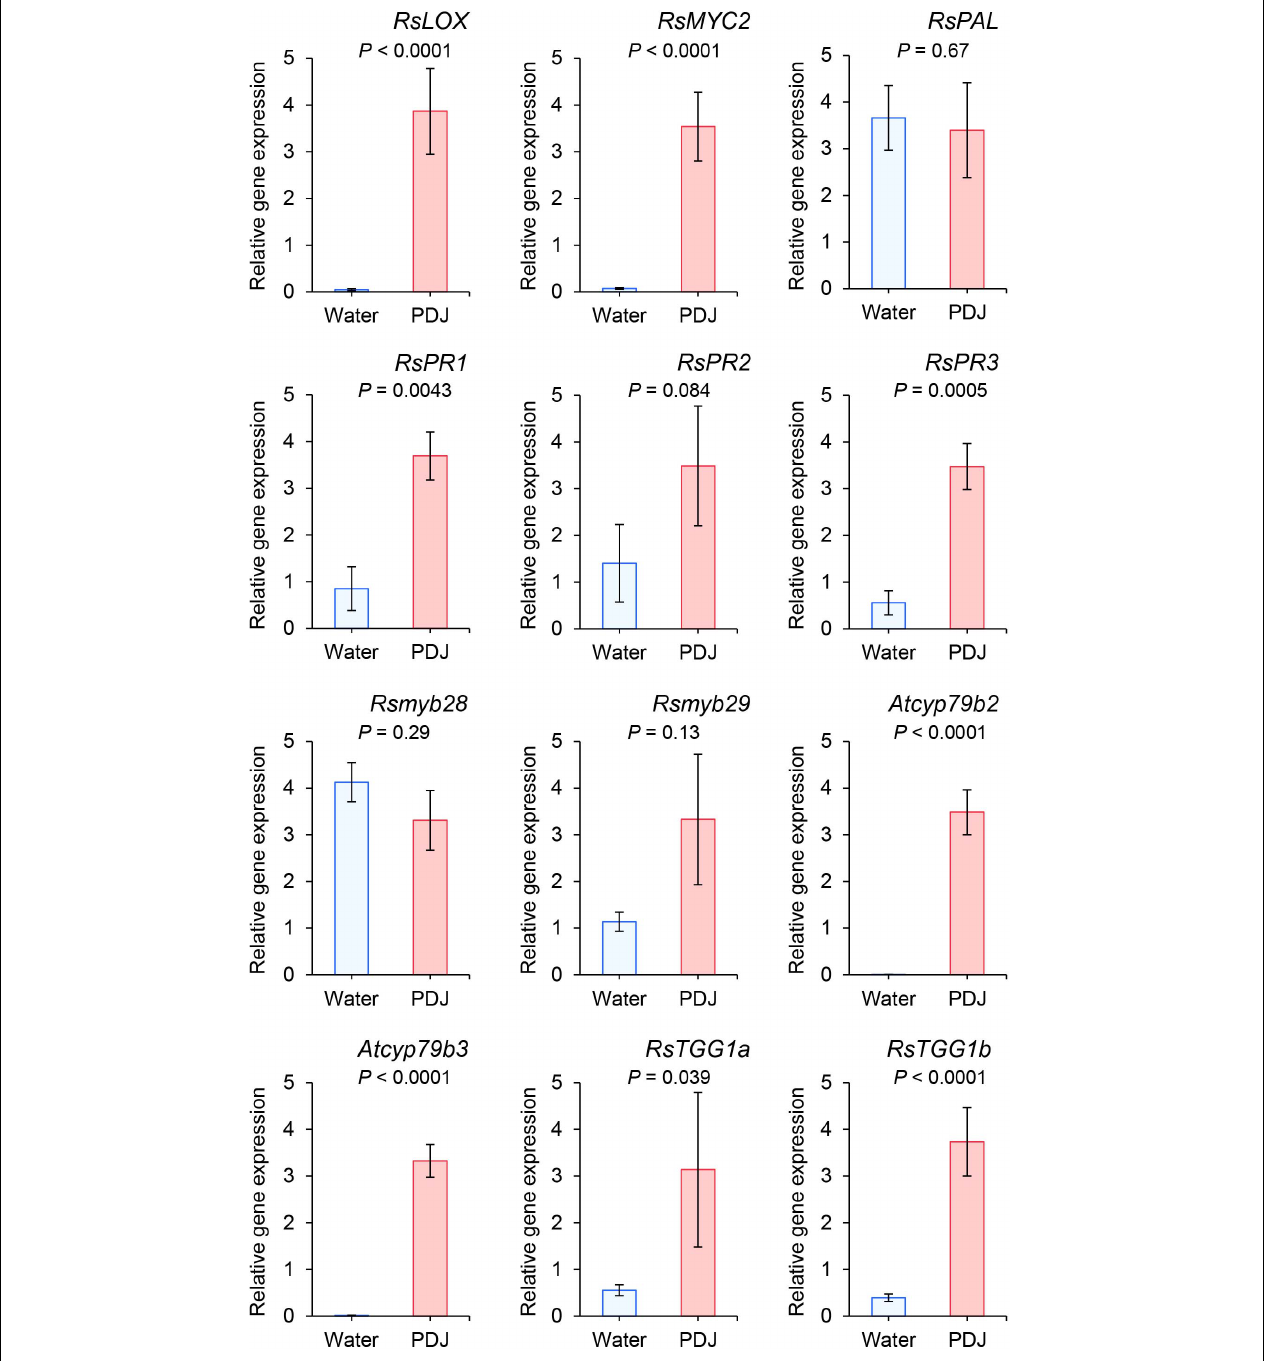
FIGURE 5 | Expression levels of RsLOX and RsMYC2 , which are regulated by the jasmonic acid signaling pathways, RsPAL , RsPR1 , RsPR2 , and RsPR3 , which are regulated by the salicylic acid signaling pathways; Rsmyb28 and Rsmyb29 , orthologs of Atmyb28 and Atmyb29 which regulated aliphatic glucosinolate biosynthesis, Rscyp79b2 and Rscyp79b3 , orthologs of Atcyp79b2 and Atcyp79b3 which regulate indole glucosinolate biosynthesis; and RsTGG1 and RsTGG2 , orthologs of myrosinase genes, AtTGG1 and AtTGG2 . The number of replications for all genes was five, except for RsPR1 ( n = 4) for PDJ-treated Japanese radish plants ( t -test).